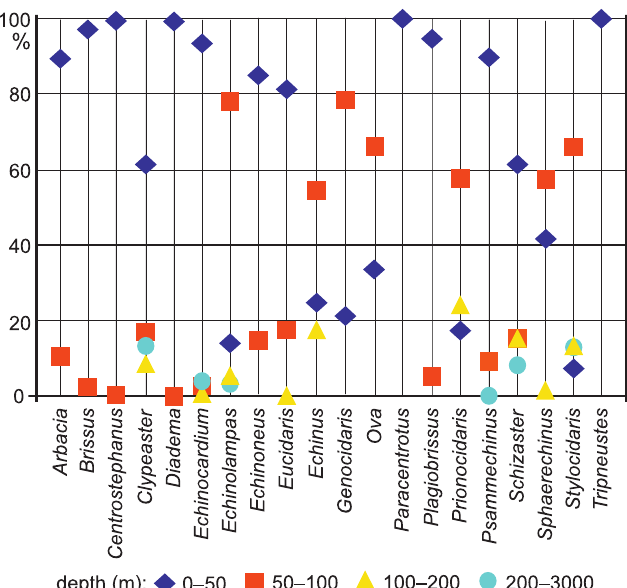
Fig. 2. Current distribution by depth of shelf-preferring/exclusive echinoid genera that still live or lived in Mediterranean during the late Cenozoic. Data are expressed in percentage of the centennial bathymetric records col- lected by OBIS